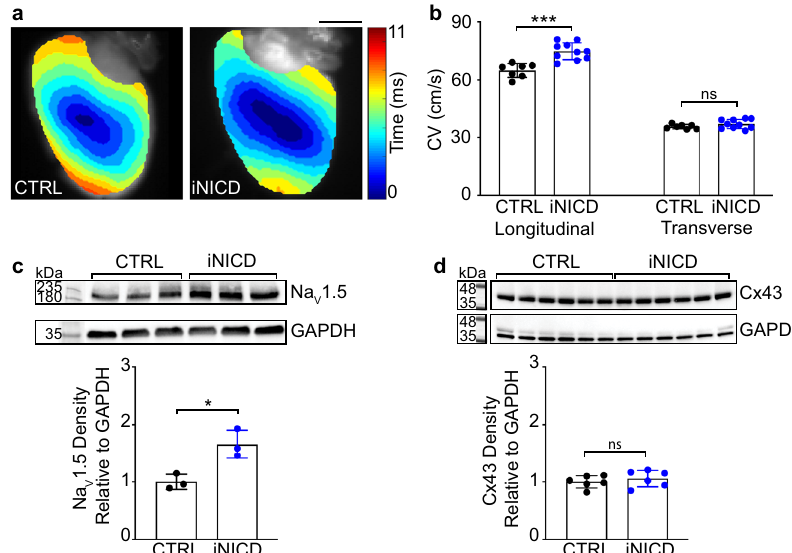
Fig. 6 Transient iNICD-mediated, cardiomyocyte-speci fi c Notch activation persistently increases conduction velocity and Na V 1.5 protein expression. a Representative activation maps and b conduction velocity measurements of control (CTRL, black) α MHC-rtTA ; tetO_NICD (iNICD, blue) murine hearts after 3-week doxycycline induction and 16-week washout ( n = 7 biologically independent CTRL mice; n = 9 biologically independent iNICD mice; Longitudinal *** P = 0.00019, Transverse P = 0.18). c , d Western blot and quanti fi ed densitometry from CTRL versus iNICD hearts after 3-week doxycycline induction, 52-week washout for Na V 1.5 ( n = 3 biologically independent samples per condition, * P = 0.026) and Cx43 ( n = 6 biologically independent samples per condition, P = 0.47, ladder was run in parallel on a separate gel to allow for quantitative comparisons on the same blot). All P values determined by two-way unpaired t test. All bar graphs are represented as mean ± SD. Source data are provided as a Source data fi le.